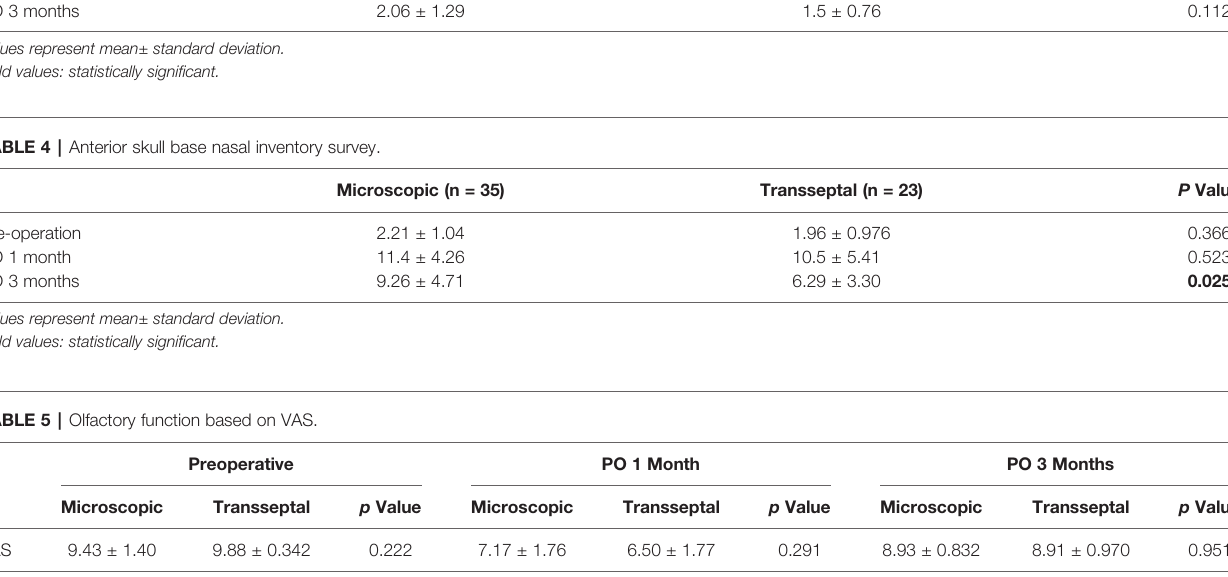
Values represent mean± standard deviation. Bold values: statistically signi fi cant.